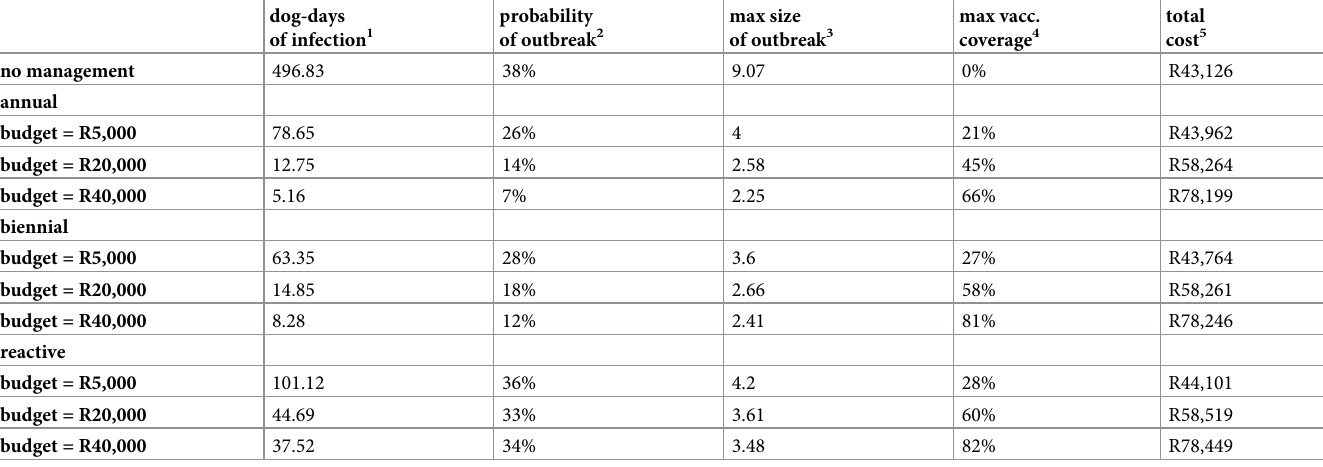
Table 3. Baseline (only adult and juvenile vaccination) scenario